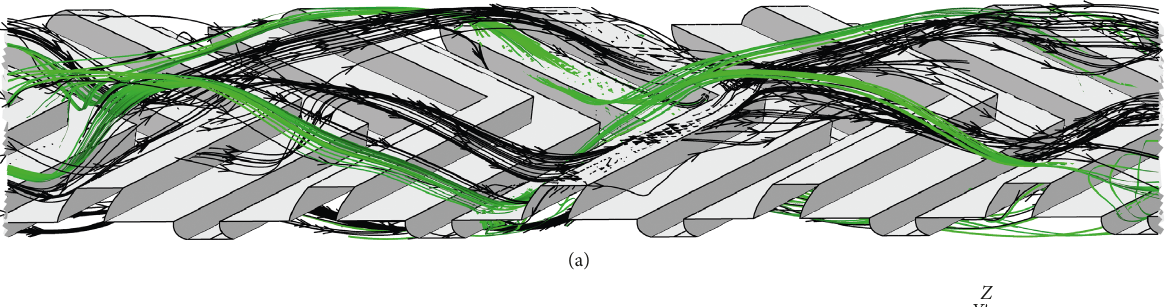
30 ° and Re 6000 for (a) V- (cid:28) (cid:28)